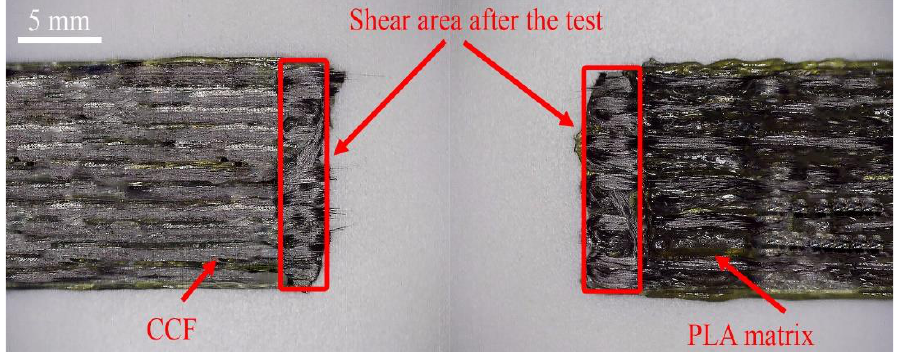
Figure 7. The 11 printing lines of the G4 group specimen after the testing.